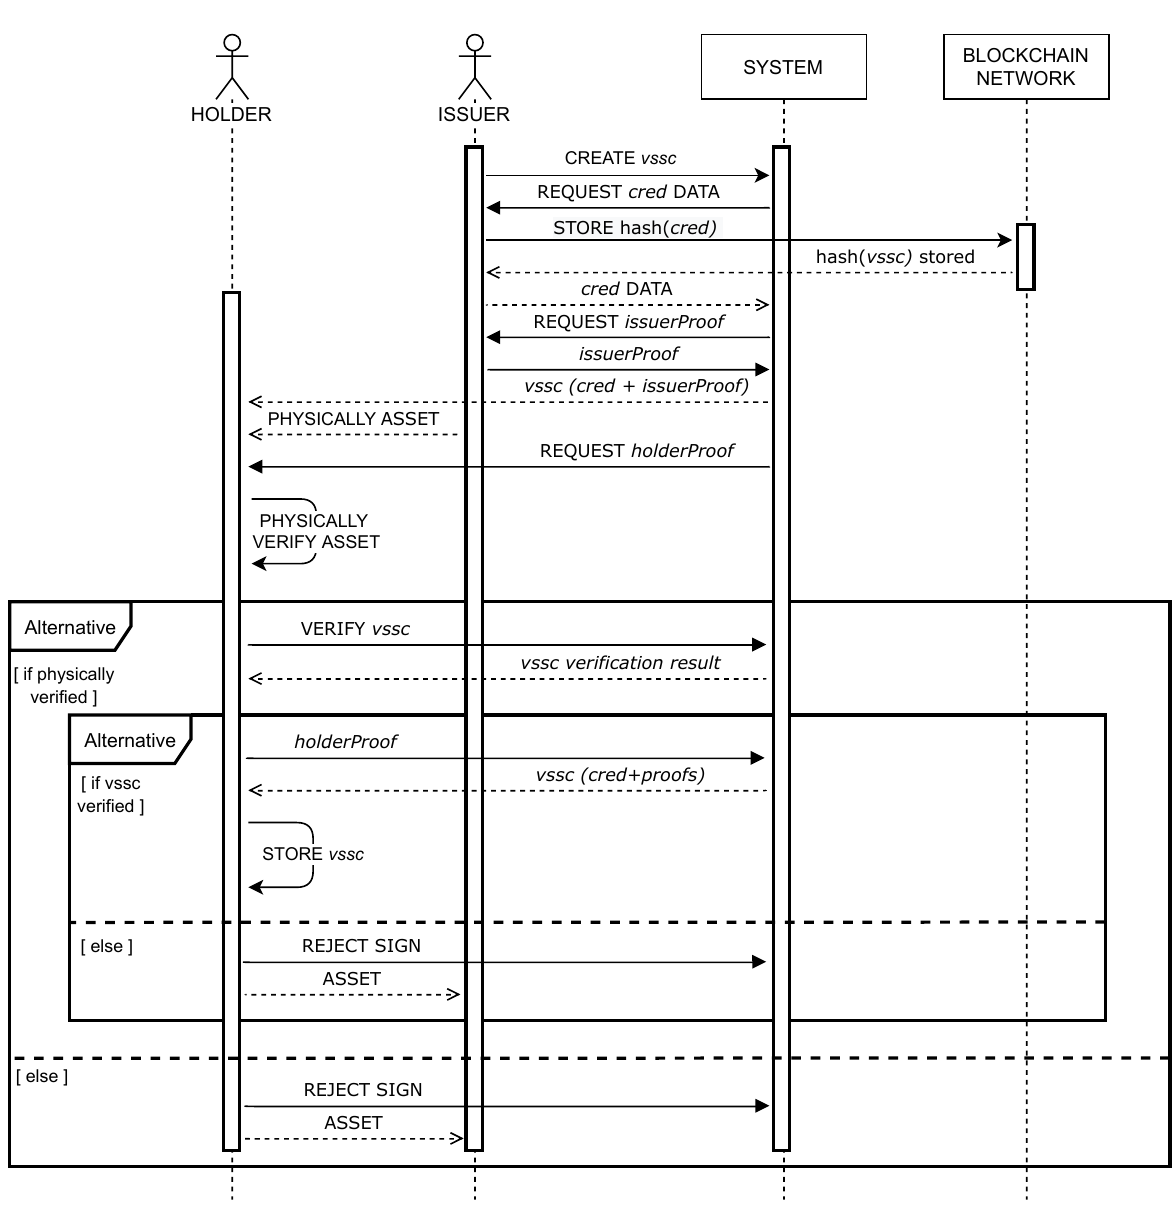
Figure 2. Verifiable supply chain credential issuing